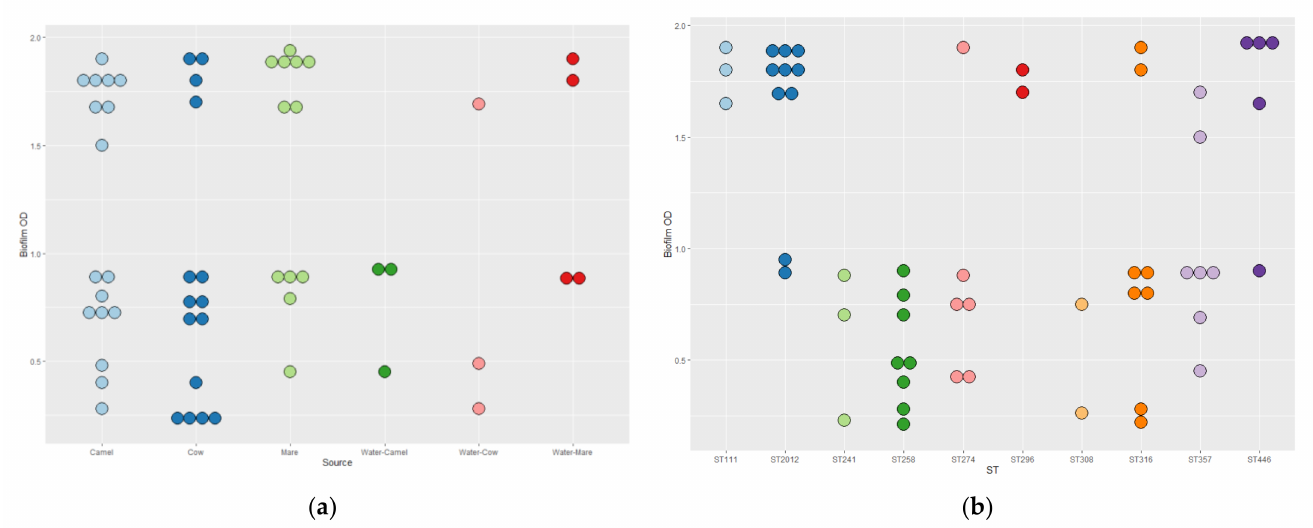
Figure 5. OD 570 values indicate the amount of bacterial biofilm among the P. aeruginosa isolates ( n = 54) with regard to the isolation source ( a ) and the isolate sequence type ( b ): negative (0.21–0.28),